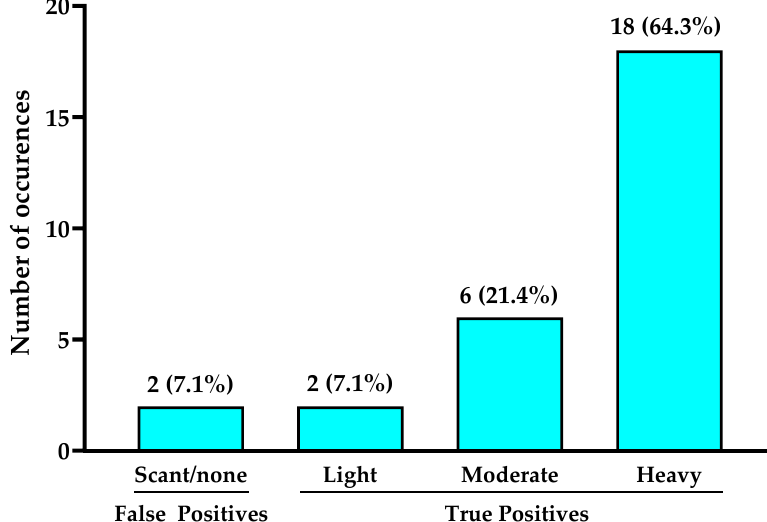
Figure 3. Total bacteria load quantified via semi-quantitative culture analysis from sampled regions of cyan fluorescence. Numbers on top of bars indicate number of study wounds in each category. Wounds where light to heavy bacterial loads were identified were considered true positives. In one wound, cyan fluorescence was observed but microbiological analysis did not detect bacterial load, thus it was considered a false positive.